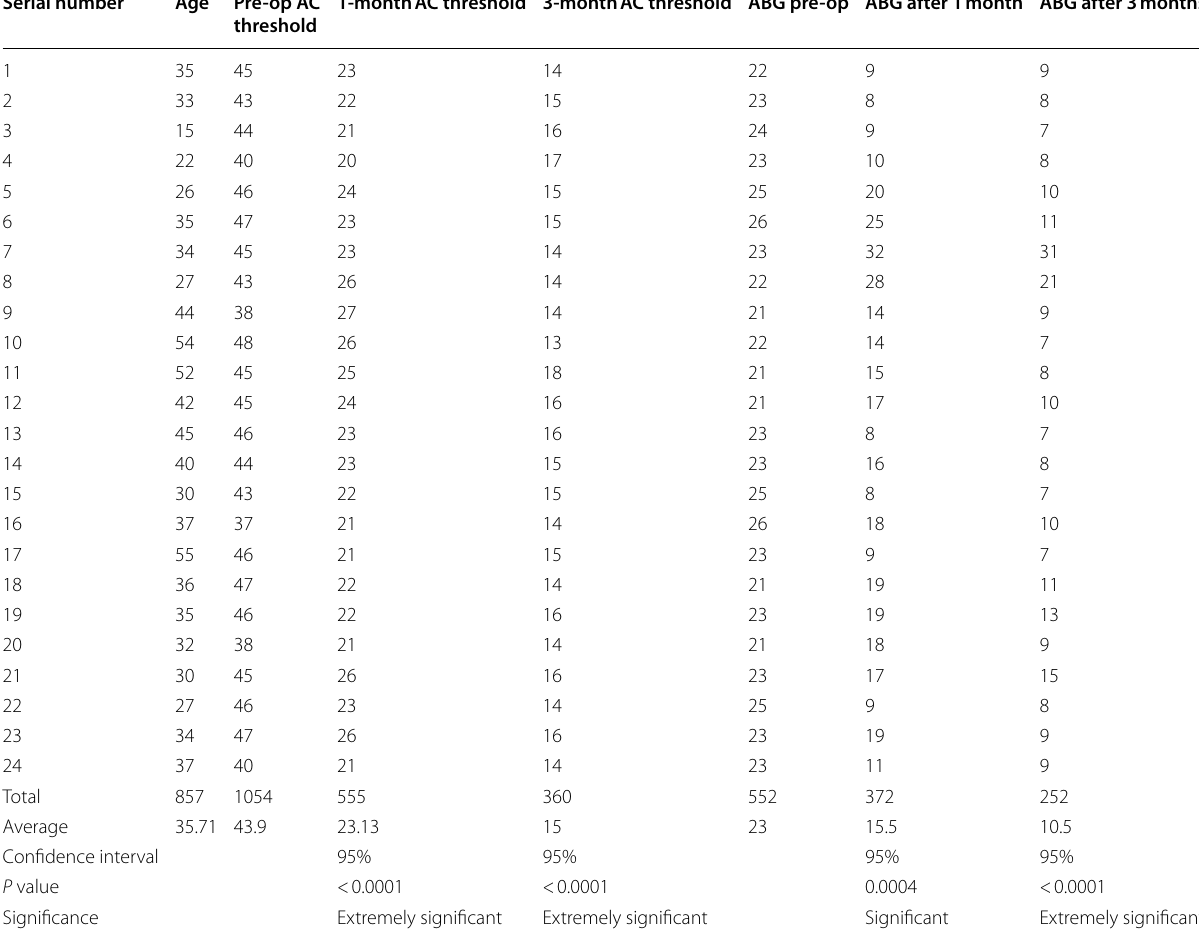
Abbreviations : AC air conduction threshold, ABG air-bone gap